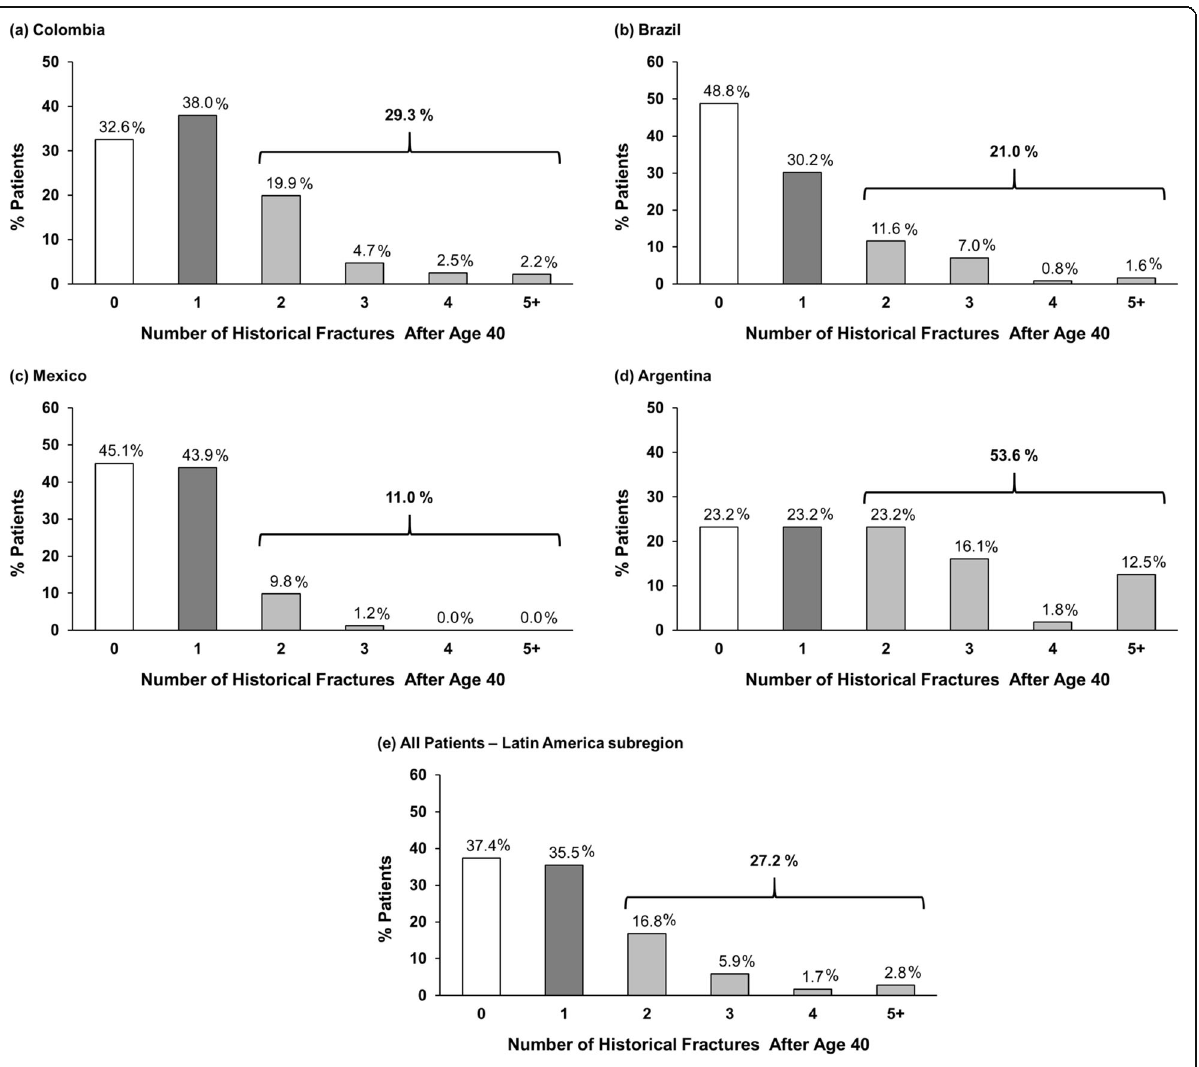
Fig. 2 Percent of patients with osteoporotic fractures after 40 years of age. a Colombia ( N = 277); ( b ) Brazil ( N = 130); ( c ) Mexico ( N = 83); ( d ) Argentina ( N = 56); ( e ) All Patients - Latin America subregion ( N = 546). Note: Percentages are calculated using n, the number of valid (not missing or unknown) responses for each